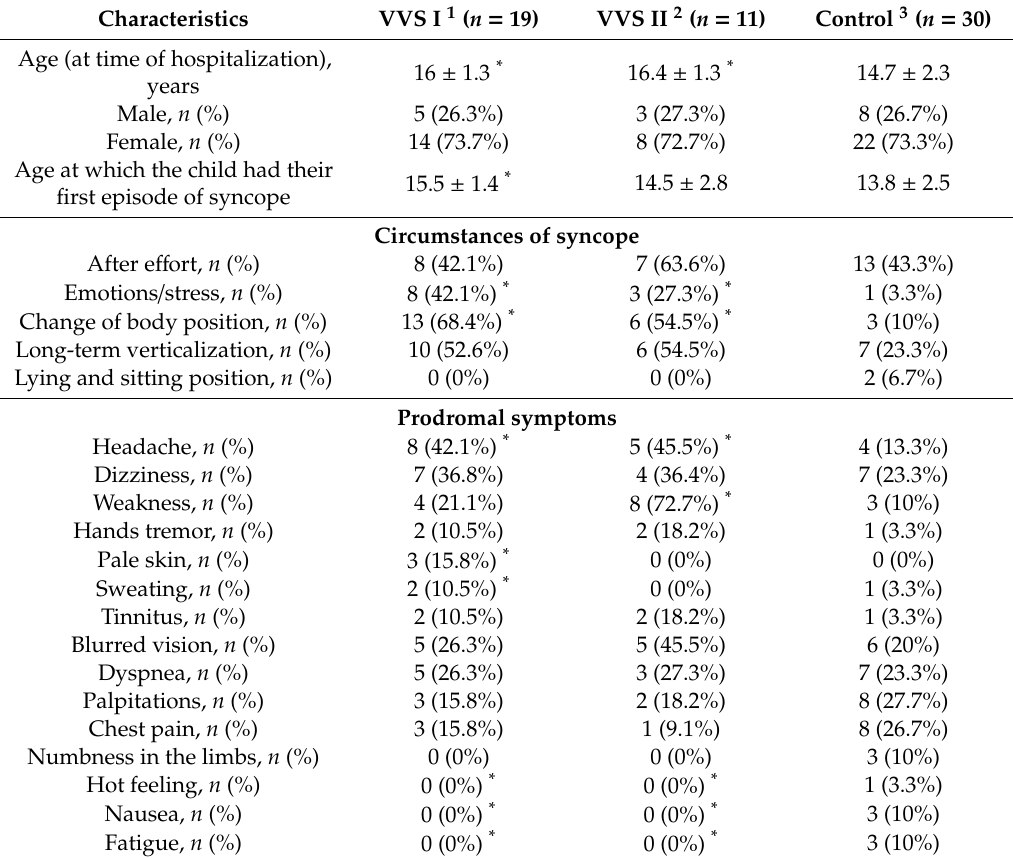
Table 1. Characteristics of children with vasovagal syncope, either with or without morphological changes on the electrocardiogram, compared to those with psychogenic pseudosyncope